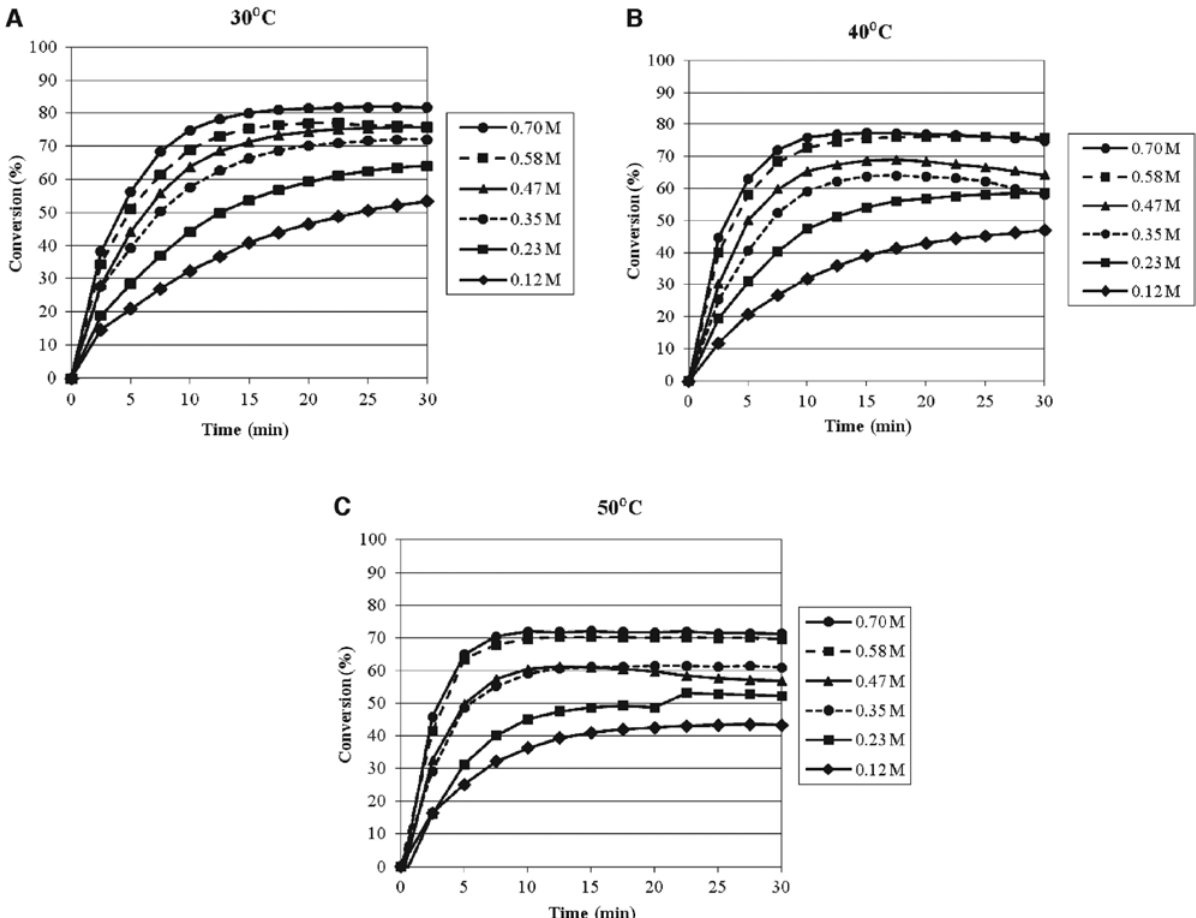
Figure 6: Batch experiment results for removal of 5 ppm of benzaldehyde when tris(hydroxymethyl)aminomethane (TRIS) is applied as a scavenger in a water/ethanol mixture (70%/30% v/v) performed with six different concentrations of TRIS (0.12 M, 0.23 M, 0.35 M, 0.47 M, 0.58 M, 0.7 M) and at three different temperatures (A) 30 ° C, (B) 40 ° C and (C) 50 ° C. Standard deviations are below 1% and excluded from the